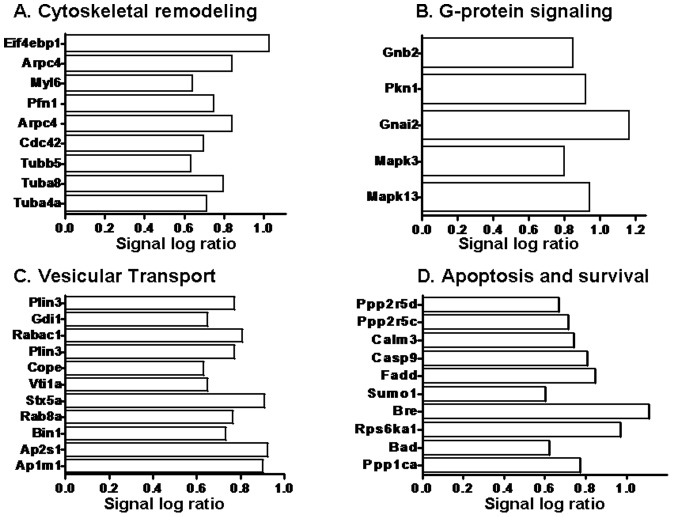
Functional classification of differentially expressed genes.Genes (FC>1.5, p<0.05) are broadly grouped into selected functional categories: (A) cytoskeletal remodeling, (B) G-protein signaling, (C) vesicular transport, and (D) apoptosis and survival. The abscissa refers to the signal log ratio (SLR), representing the log2 of the average change between transcript expression in saline- and 5-HT-infused megakaryocyte populations (SLR = 1 or log2 of 1  =  FC of 2).